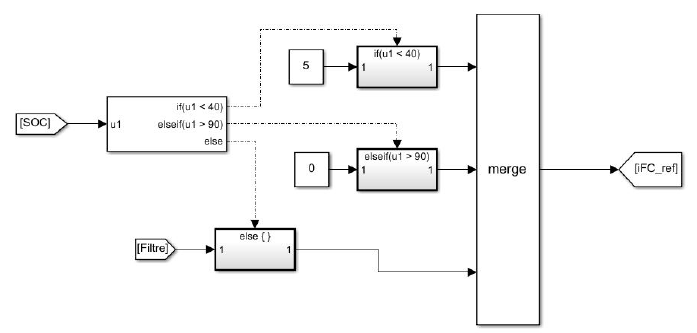
Figure 19. Block distribution for the selection of the different EMS zones. The simulation results for high-SOC for the semi-active hybrid configuration are shown in Figure 20. It can be seen that the battery operation is very similar to the passive case: voltage drops at currents peaks and a SOC that starts and ends at similar values. The big difference is appreciated in the FC behavior. With respect to the passive configuration, the FC current is higher and voltage is lower, as expected by the addition of the converter. Larger oscillations are also present in both FC current and voltage. Furthermore, the flow rates follow the oscillatory form of current and voltage. This is due to the low-pass filter used to generate the FC current reference. The actual filter bandwidth maintains the performance of the battery close to the one obtained in the passive configuration case. If a narrowed bandwidth is chosen, then the FC current and voltage oscillations will be smaller but the peaks in the battery current will be larger, causing larger voltage drops in the dc bus and more degradation of the battery. In this manner, the low-pass filter regulates the grade of hybridization of the system.